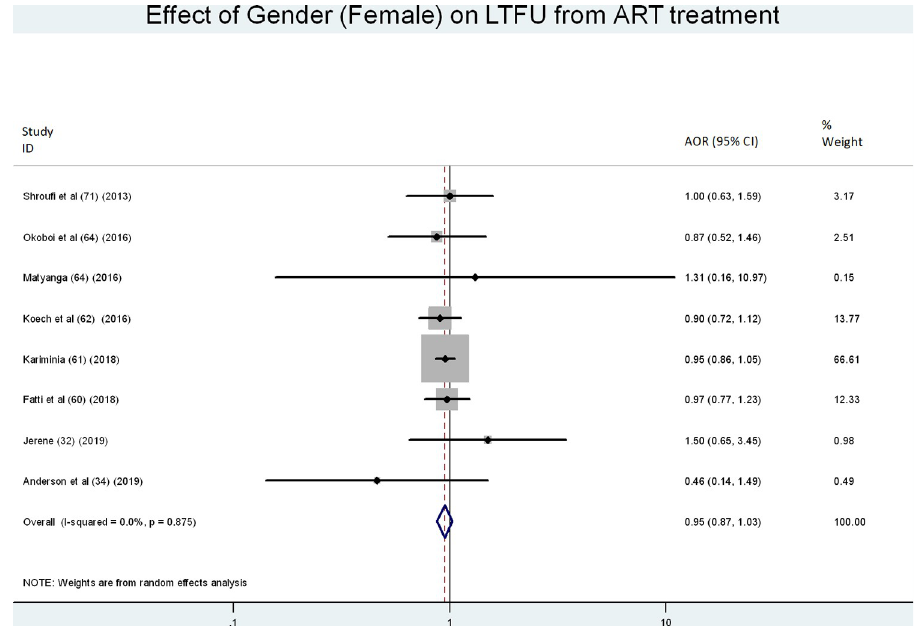
Fig 8. Forest plot showing the association of gender and LTFU in ART